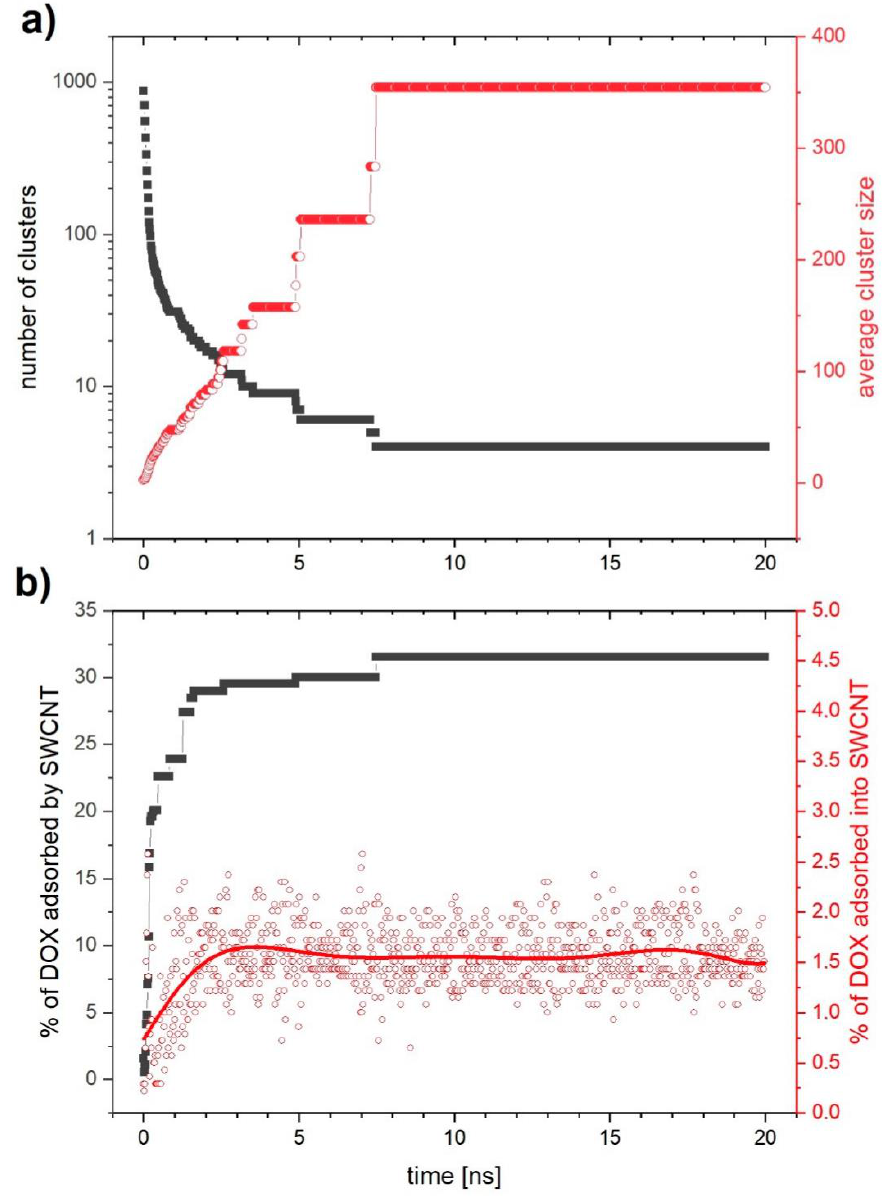
Figure 6. Molecular dynamics (MD) simulation of single-wall carbon nanotube: ( a ) the number of aggregates (gray) and mean degree of aggregation (red); ( b ) fraction of DOX molecules that are adsorbed onto CNTs (gray), and that are adsorbed inside the nanotube (red) as a function of time.